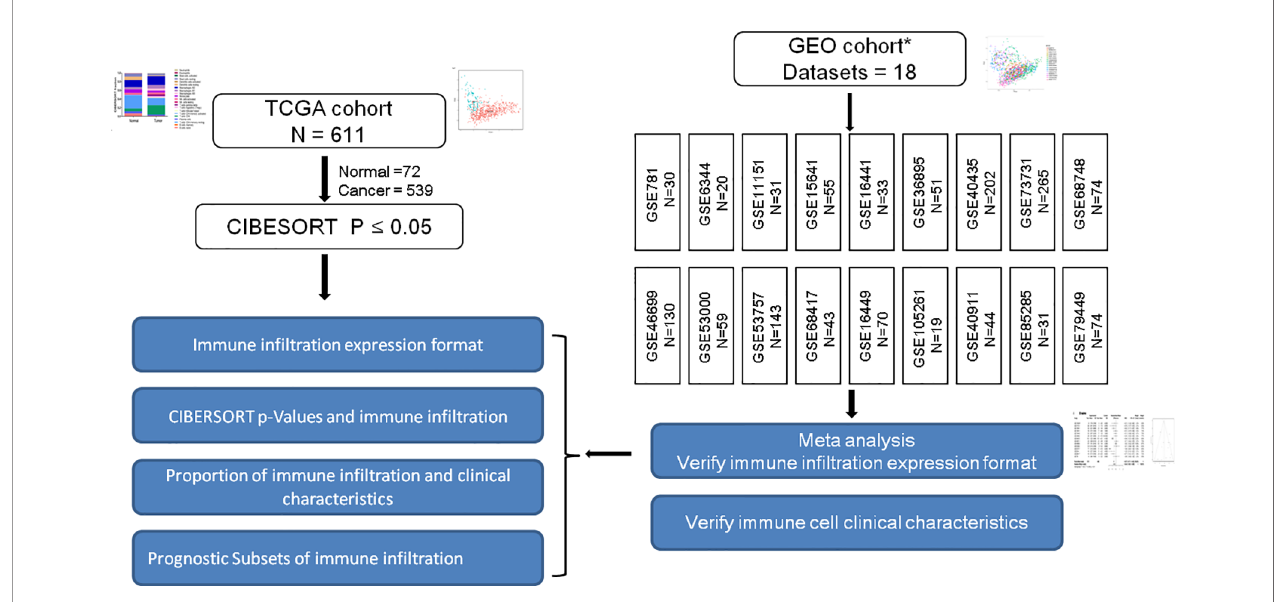
FIGURE 1 | Is a representation of the fl owchart of the overall study design. RCC gene expression data retrospectively selected from TCGA and GEO database up until June 2019. The constituent pattern of the immune microenvironment of RCC was systematically described and the differences between diverse immune clusters and gene subtypes were explored. Immune in fi ltration expression and clinical characteristics in GEO cohorts were veri fi ed. * Figure S1 shows the general work algorithm of the GEO